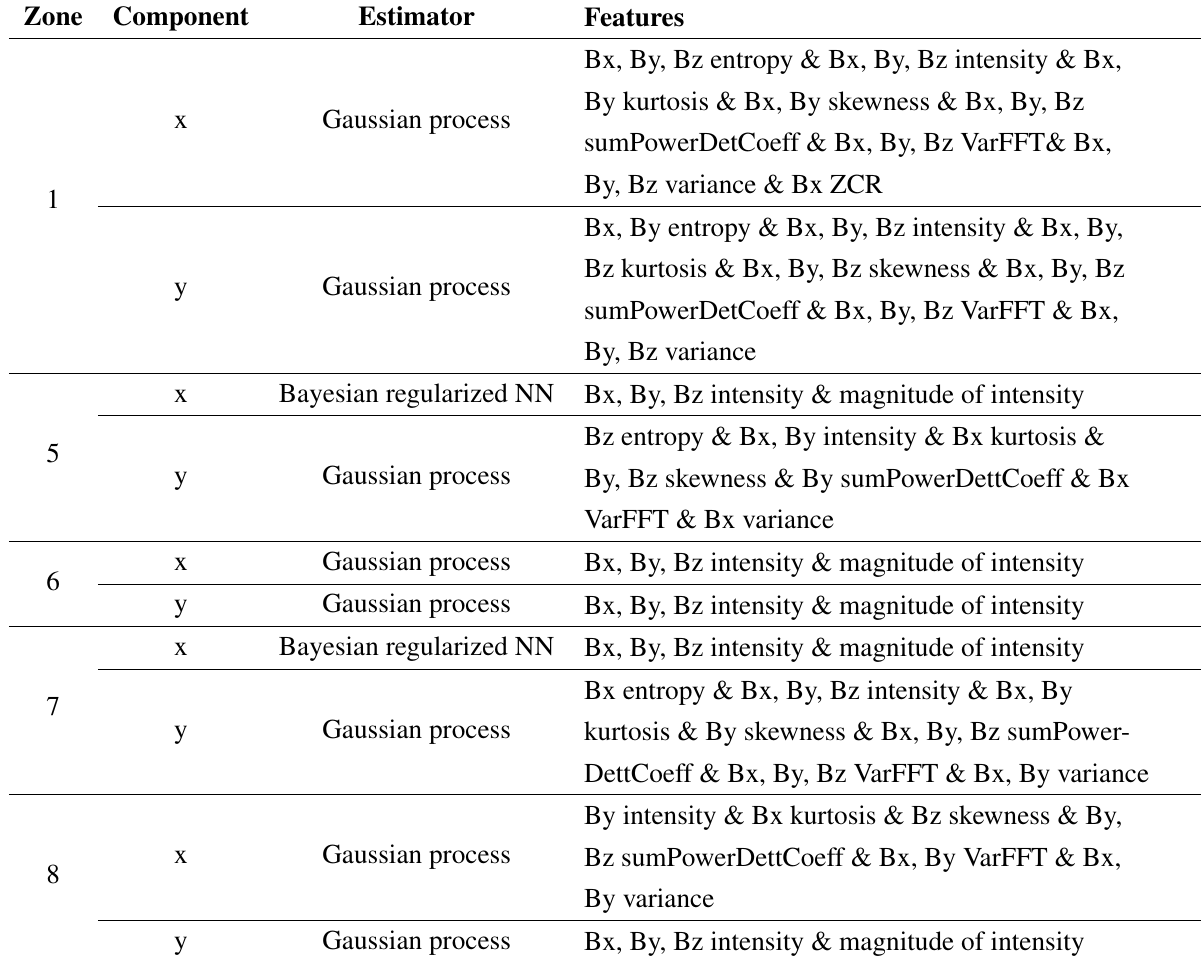
Table 6. Estimators selected for each zone in Building A with the features that they take as